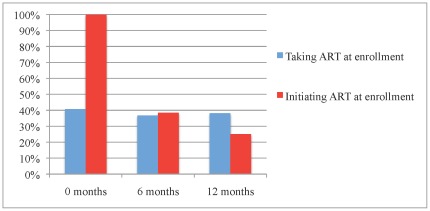
Detectable HIV RNA by ART history at enrollment.